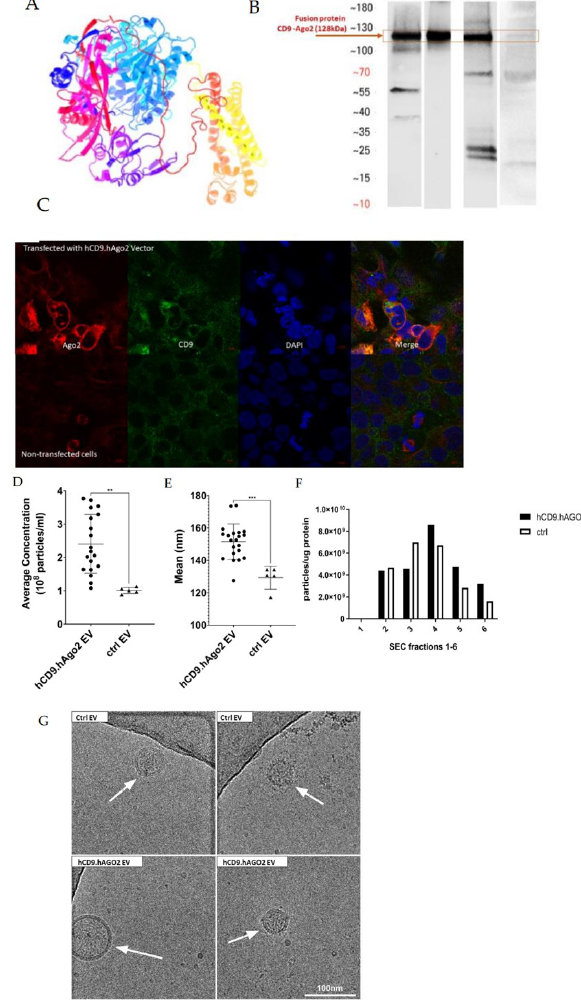
Figure 1. Construction of the fusion protein hCD9.hAGO2. ( A ) The protein folding by the online prediction software (Phyre.2) for hCD9.hAGO2 protein. ( B ) Western blot for hCD9.hAGO2 fusion protein after transfection to HEK293T cells (48 h timepoint) confirmed the correct fusion protein formation. Predicted molecular weight of 129 kDa was observed both in the cells and in the EVs. Unmodified gel images of western blot are supplemented in Figure S2. ( C ) Cellular colocalization of fusion protein domains was studied in HEK293T cells (24 h timepoint). The presence of recombinant hCD9.hAGO2 was confirmed by confocal microscopy after double immunofluorescence staining with CD9 and AGO2 antibodies. ( D ) Concentration of EVs in hCD9.hAGO2 EVs larger than in control groups (EVs from unmodified HEK293T cells). Measurement was made with Nanosight NS300 Nanopraticle tracking analysis (NTA). Data are presented as mean ± SD. hCD9.hAgo2 EV vs. ctrl EV p -value 0.0021 ( E ) Mean size of hCD9.hAGO2 EVs were determined by NTA and were observed to be statistically larger compared to the control EV group. Data are presented as mean ± SD. hCD9.hAgo2 EV vs. ctrl EV p -value 0.0002 ( F ) Protein concentration from different fractions of SEC EV isolation was measured and particle number to protein amount ratio was calculated for different fractions in both hCD9.hAGO2 EVs and control EVs. According to the manufacturer’s protocol (Izon Bio), fractions 2–4 have the highest amount of EVs and less contamination of proteins. We observed that compared to control EVs, hCD9.hAGO2 EVs have the highest particles to protein ratio later, at fraction 4. This may be due to the observed increased size of the EV population after hCD9.hAGO2 expression. ( G ) Cryo-EM of hCD9.hAgo2-engineered EVs. Two representative images are shown for control EVs (top row) and hCD9.hAGO2 expressing EVs (bottom row). White arrows indicate the EVs in the samples. We observed no differences in EV structure with FP loading. ** p -value < 0.005, *** p -value <